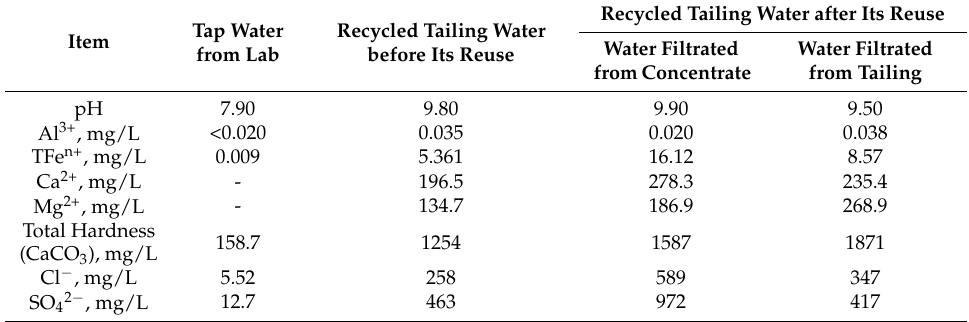
Table 3. Chemical analysis of the tap water in the lab and recycled tailing water before/after its reuse in the flotation